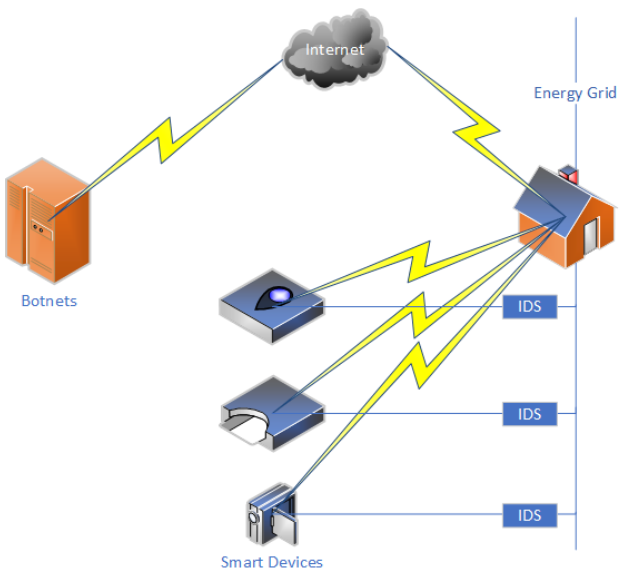
Figure 2. Topology of the monitoring devices in a household.